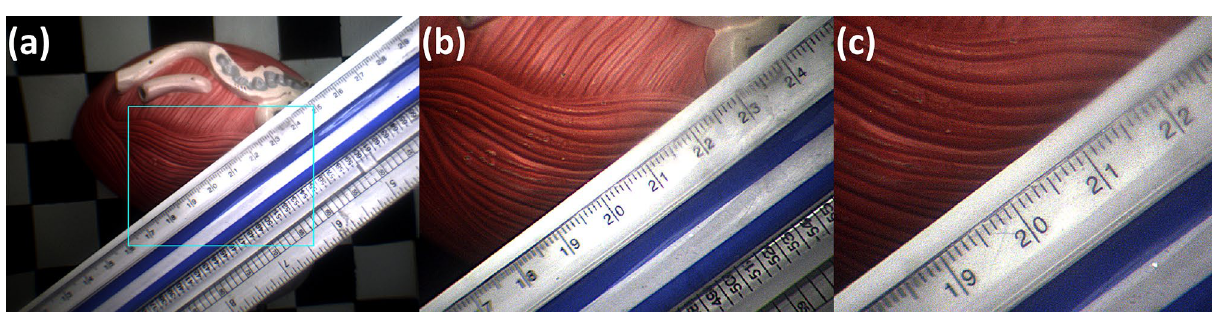
Figure 6. MRFL images used to measure the viewable area at the nominal working plane. The field of view was measured for the ( a ) wide-view, ( b ) 2× zoomed-view, and ( c ) 3×